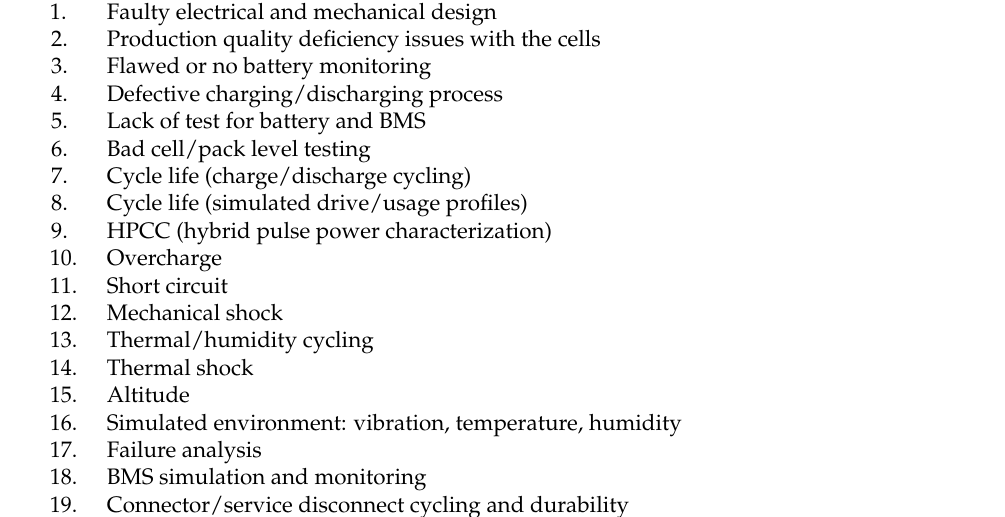
Table 4. Causes of battery fire as part of BMS safety functions